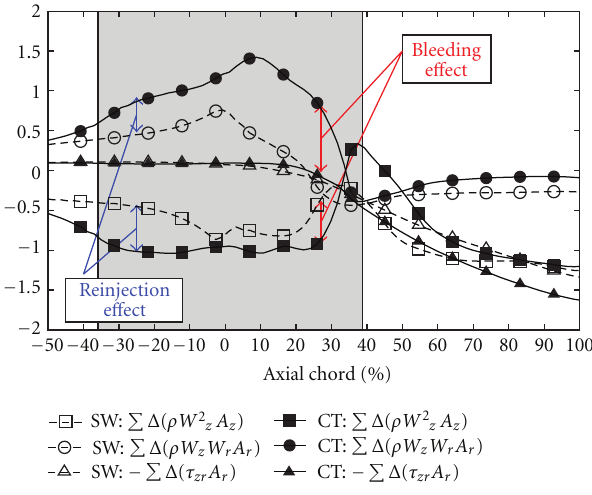
Figure 18: CBUAA with and without CT: cumulative sum in the axial direction of the principal terms involved in the axial momen- tum